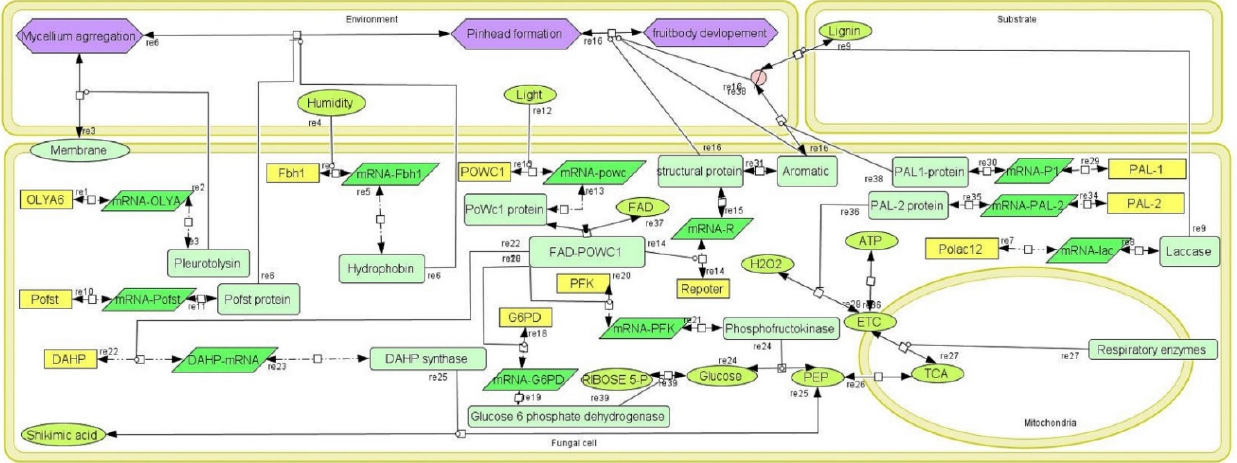
Figure 2. Fruiting mechanism in Pleurotus constructed using Cell Designer in fungal cells, in connection with the substrate and environment. The diagram shows the simple molecules, proteins, mRNA, DNA, enzymes, catalysis, and inhibition, etc.